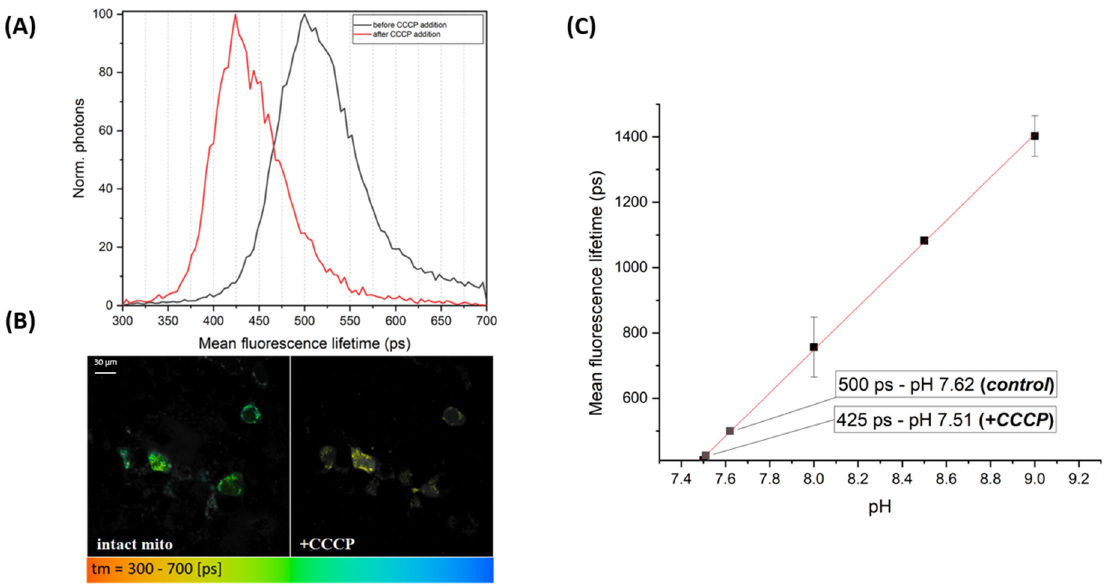
Figure 4. FLIM data recorded for the HEK293T cells expressing EGFP-Y145L/S205V in the mitochondria. ( A ) Histograms showing the distribution of the probe’s mean fluorescence lifetime in the intact mitochondria (black solid line) and after the addition of the ETC uncoupler (10 uM CCCP; red solid line). ( B ) Color-coded FLIM scans exemplifying the lifetime values recorded in the mitochondria of HEK293T cells before (right) and after (left) the addition of 10 uM CCCP (color legend is under the image gallery). Scale bar is 30 µm. A two-photon (2P) laser, λ em = 750 nm, was used for the fluorescence excitation. ( C ) Calibration curve (part of the Tm/pH dependence measured in the cytoplasm) used to determine the absolute pH values of the mitochondria. The mean lifetime and corresponding pH values are shown in the boxes.